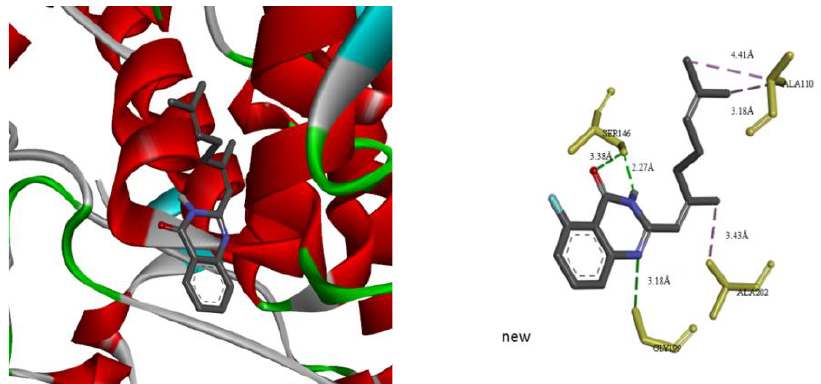
Figure 7. Molecular docking result of Q1 with mushroom tyrosinase.